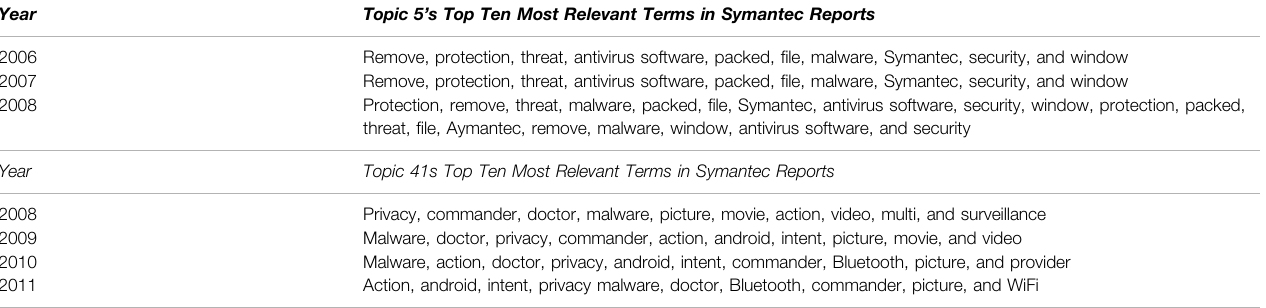
TABLE 5| Thetop ten most relevant terms from two topics inthe 100-topic Symantec Malwarereport ofthe dynamic topicmodel that correlate tothe twotrendsthat spike early and then drop off in Figure 7 100 topics. Year